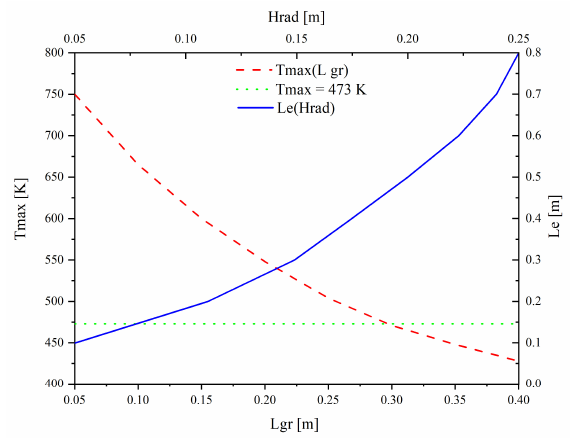
Figure 5. Maximum forest fuel surface temperature depending on the control line span and the effective control line span (typical size of the wetted forest material strip ahead of the combustion front) at different flame length s.